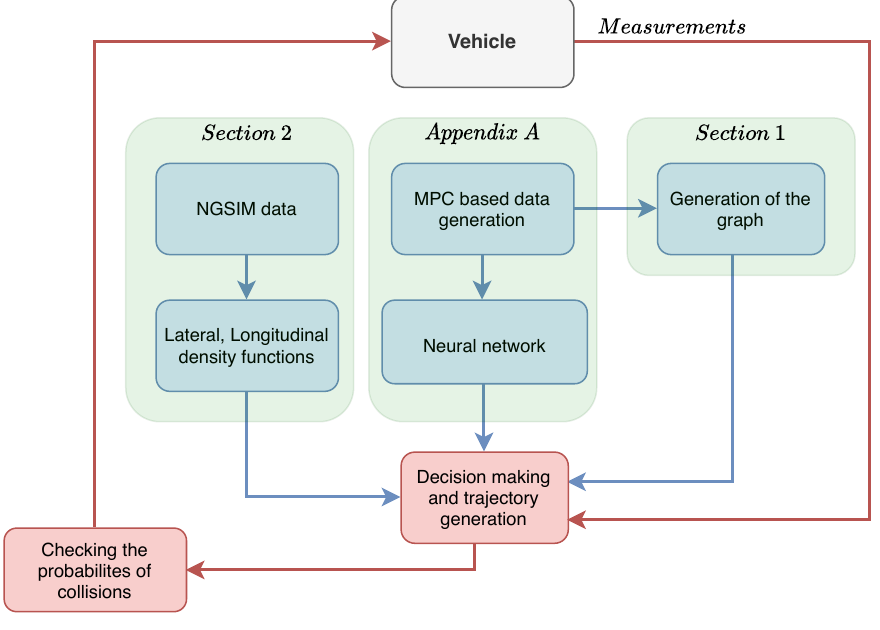
Figure 9. Structure of the